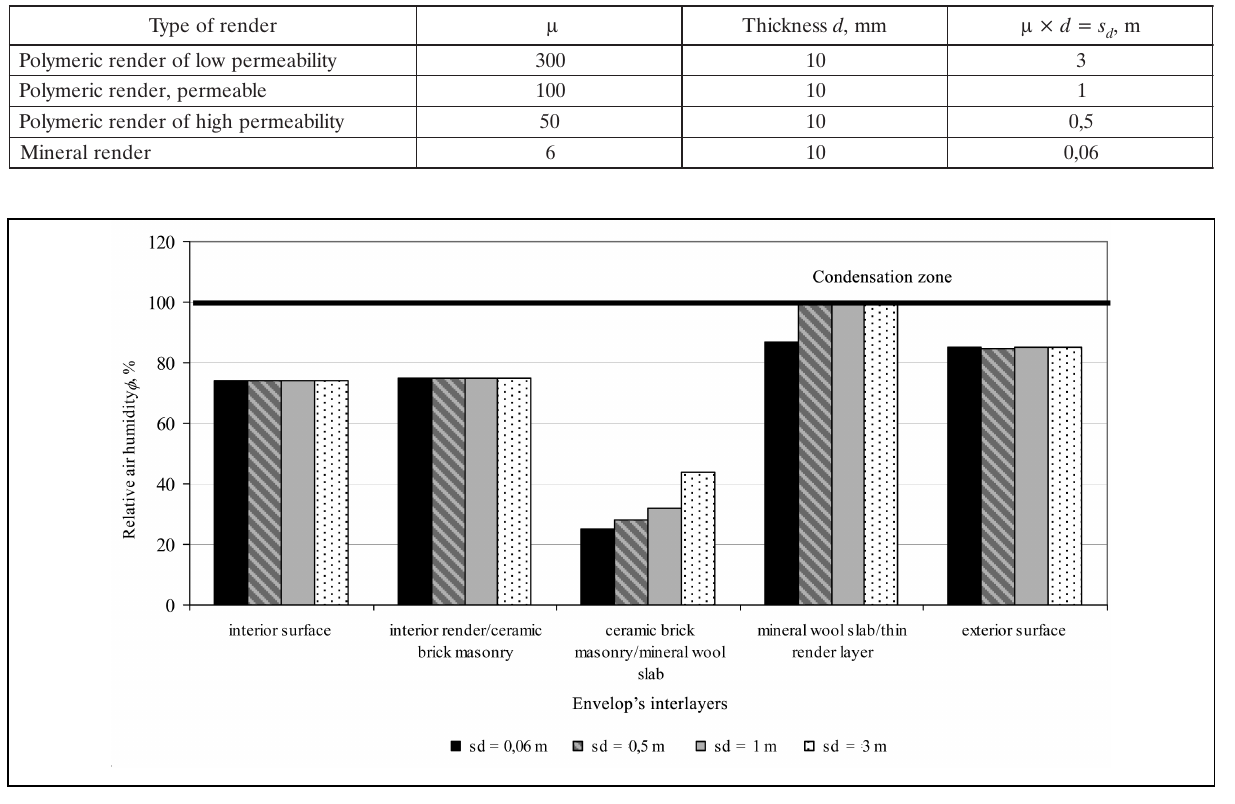
Fig 5. The impact of the thin render finish with different moisture characteristics on the moisture state of the insulated envelope